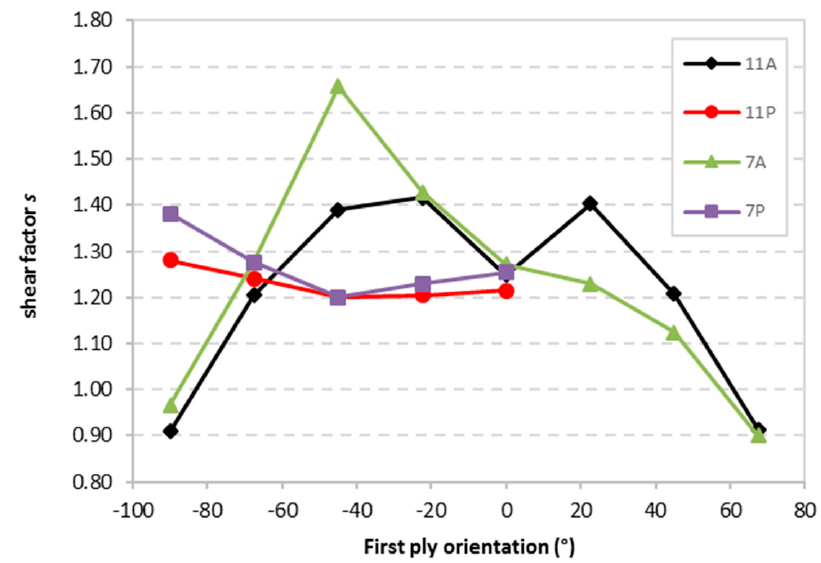
Figure 8. Calculated Timoshenko shear factor s for different combinations of tissue orientations.